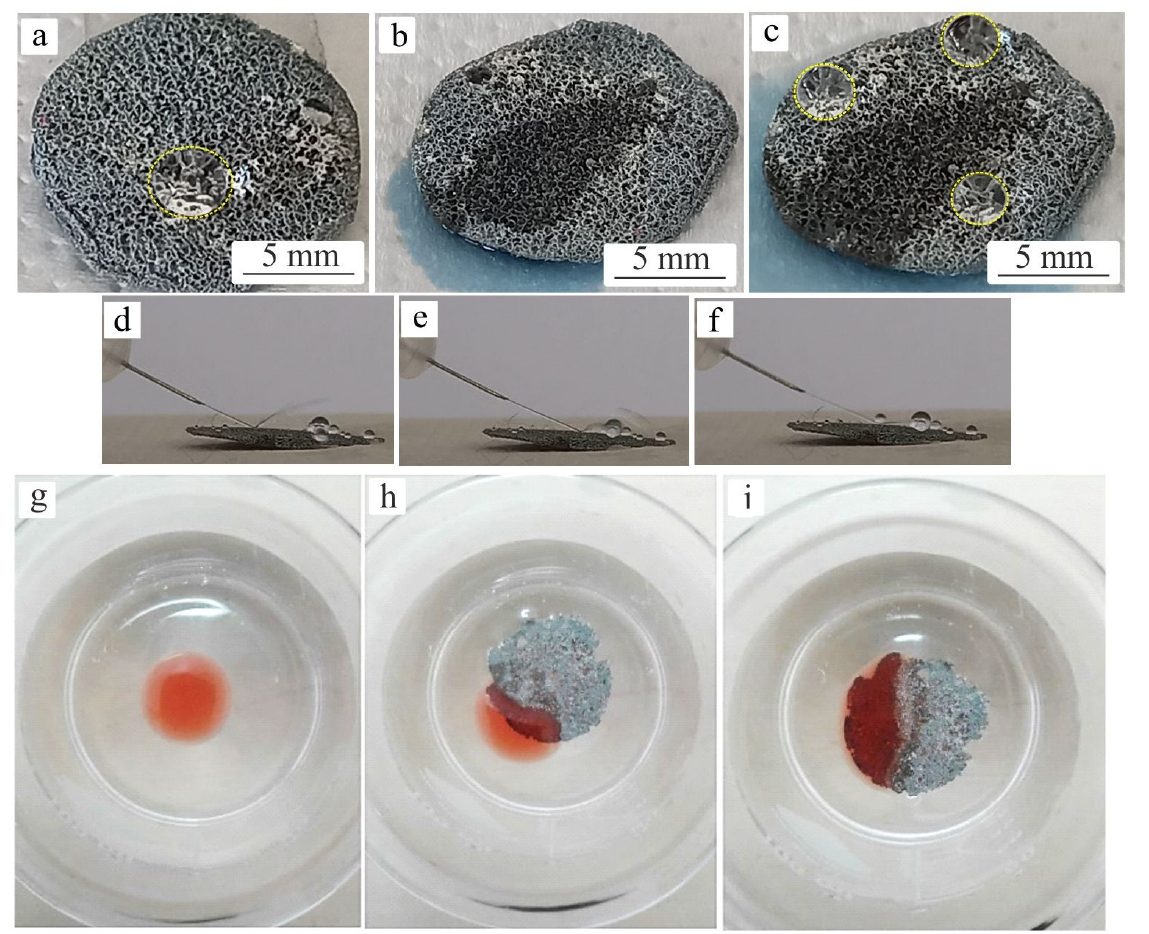
Figure 6. ( a – c ) Oil and water droplets, ( d – f ) continuous needle flushing test and ( g – i ) oil absorption test using a superhydrophobic copper foam.